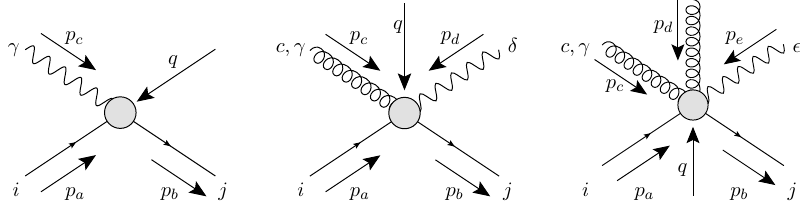
Figure 3 . Quark-photon three-point and quark-gluon-photon four- and (cid:12)ve-point functions with momentum insertion into the